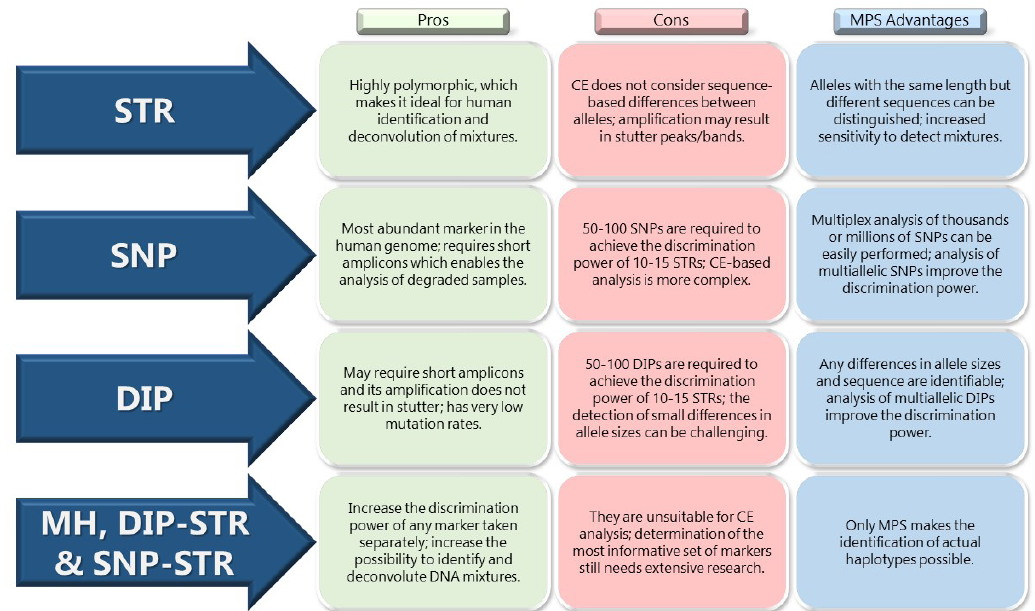
Figure 2 – Pros and cons of different sets of polymorphisms and the advantages provided by MPS for their analysis for